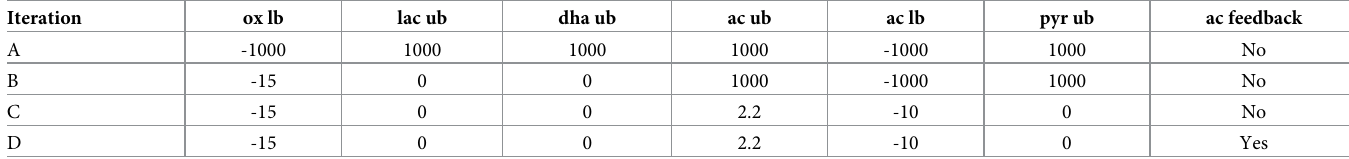
Table 1. Model parameters for reproducing fermentation. The constraints that change through the iterative modifications in our attempt to recreate the experimental observations made during the fermentation. These correspond to the differences between the different panels in Fig 2. The various values given for lb refer to the lower bounds on the corresponding exchange reaction in the COBRA model, while the ub refer to the upper bounds. The exchange reactions are: ox, oxygen; lac, lactate; dha, dihydroxyacetone; ac, acetate; pyr, pyruvate. Where applicable, both stereoisomers are affected by the changes. The acetate excretion feedback (“ac feedback”) is described in the Results and discussion